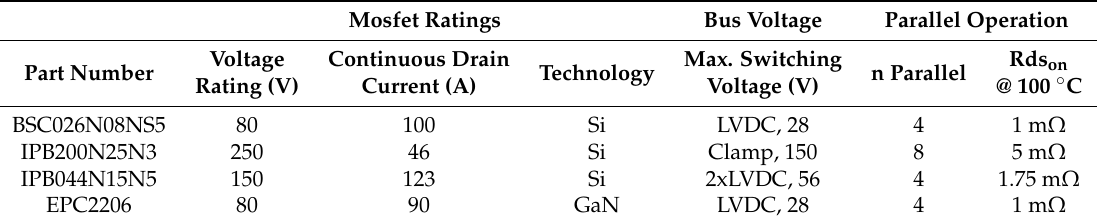
Table 2. LV MOSFETs